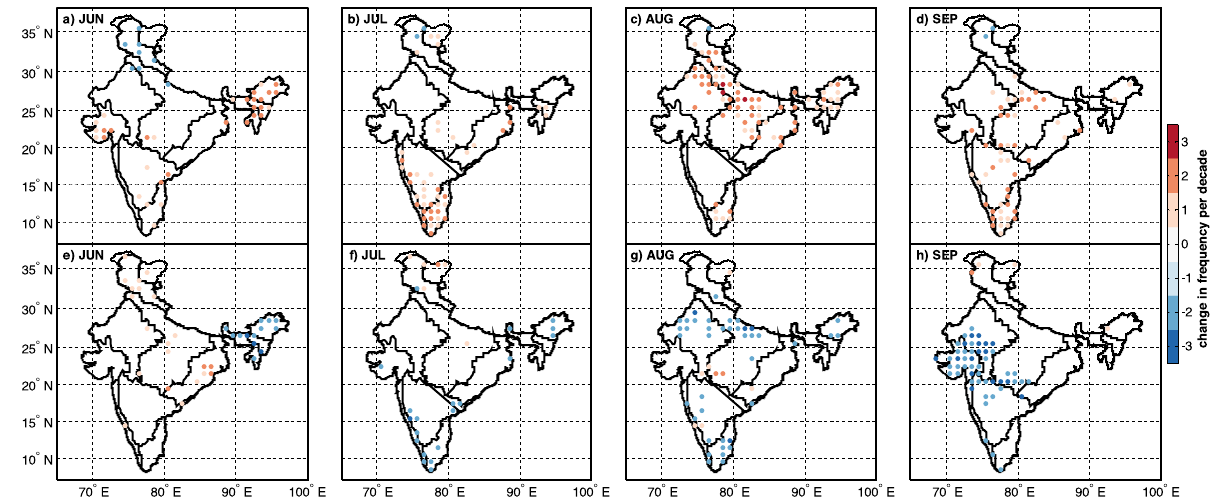
Figure 4. Spatial distribution of change in frequency per decade in the occurrence of the CDHE (Top panel, a – d ) and CWCE (Bottom panel, e – h ) for the recent period (1977–2019) relative to the base period (1951–1976) during Indian summer monsoon months across homogenous regions of India. Colorbar represents variation in the change in frequency per decade. This figure is generated using Mapping Toolbox in MATLAB R 2020b (Version 9.9 https:// in. mathw orks. com/ produ cts/ mappi ng.